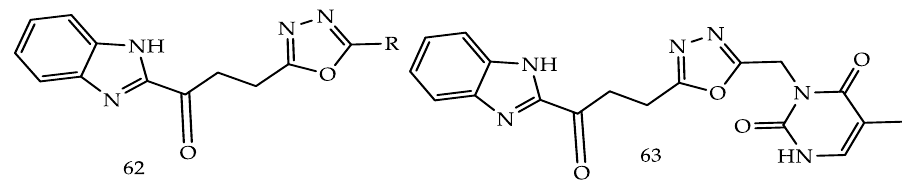
Figure 12. Chemical structures of benzimidazole moiety containing 1,3,4-oxadiazole. A new series of 1,4-benzodioxan moiety containing 1,3,4-oxadiazole derivatives (64)